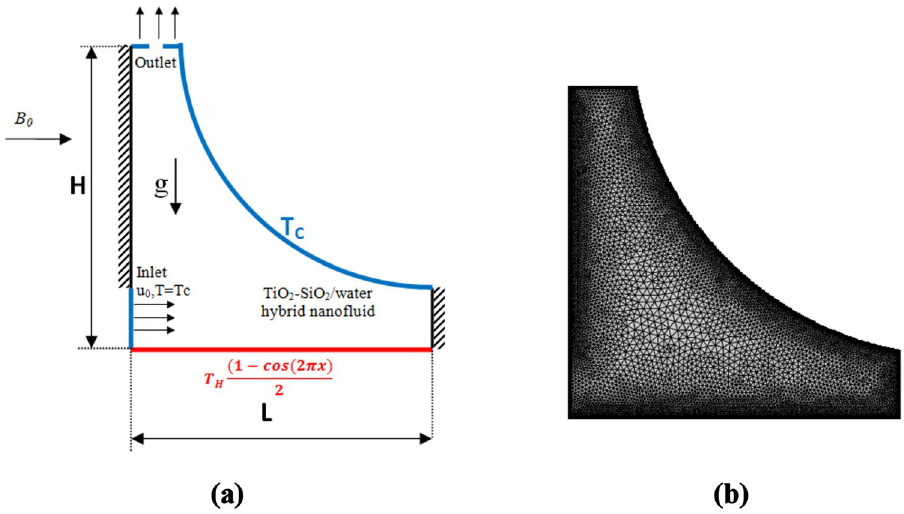
Figure 1. Vented cavity schematic representation with ( a ) boundary conditions ( b ) different configuration studies and mesh.